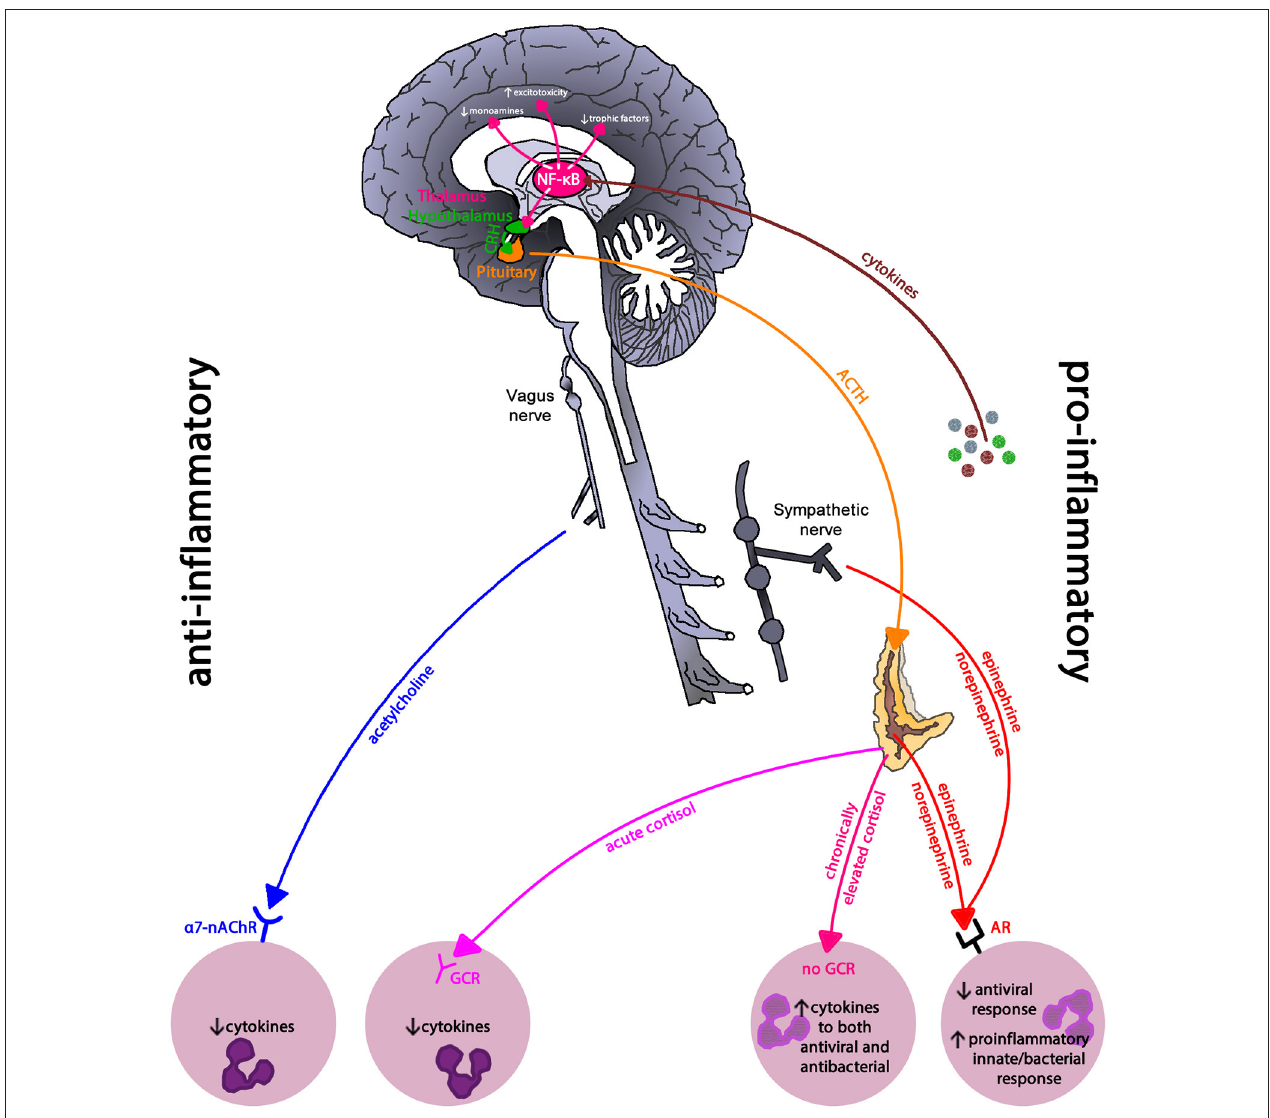
FIGURE 10 | Inflammatory regulation in depression. Inflammatory pathways use the pro-inflammatory NF- κ B signaling pathway to drive the neurohormonal changes seen in depression. Reduced glucocorticoid receptor expression and parasympathetic activity leaves immune cells in a primed pro-inflammatory state due to sympathetic nervous system dominance. NF- κ B, nuclear-factor kappa-B; CRH, corticoptropin-releasing hormone; ACTH, adrenocorticotropin hormone; a7-nAChR, alpha-7 nicotinic acetylcholine receptor; GCR, glucocorticoid receptor; AR, adrenergic receptor. This figure is an modified/updated version of a previously published figure by Bennett and Sturmberg